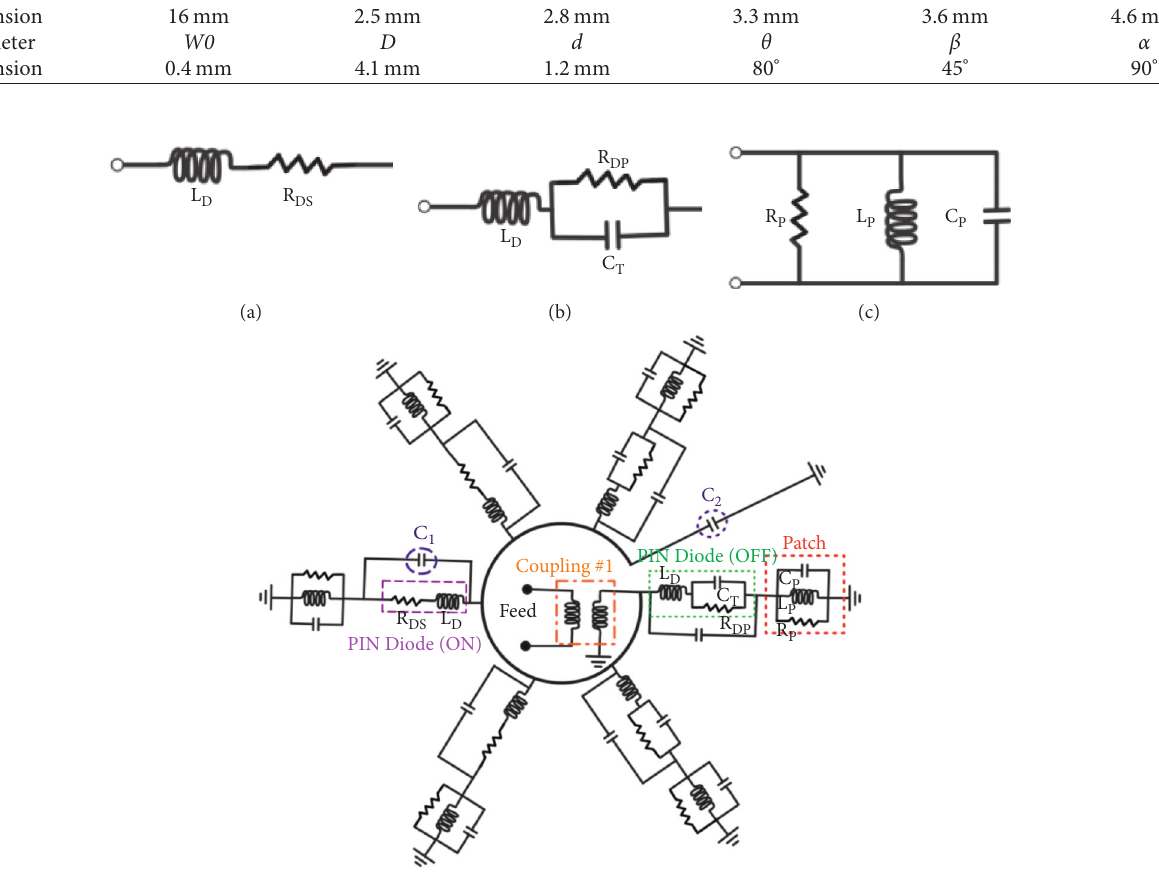
Figure 4: Equivalent circuit model. (a) Forward bias of PIN diode (ON). (b) Reverse bias of PIN diode (OFF). (c) Rectangular patch antenna. (d) Proposed